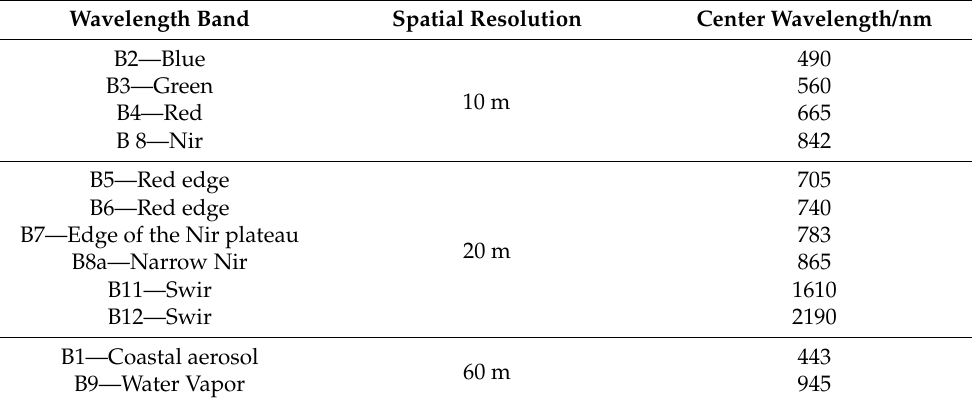
Table 1. Spectral parameters of Sentinel-2